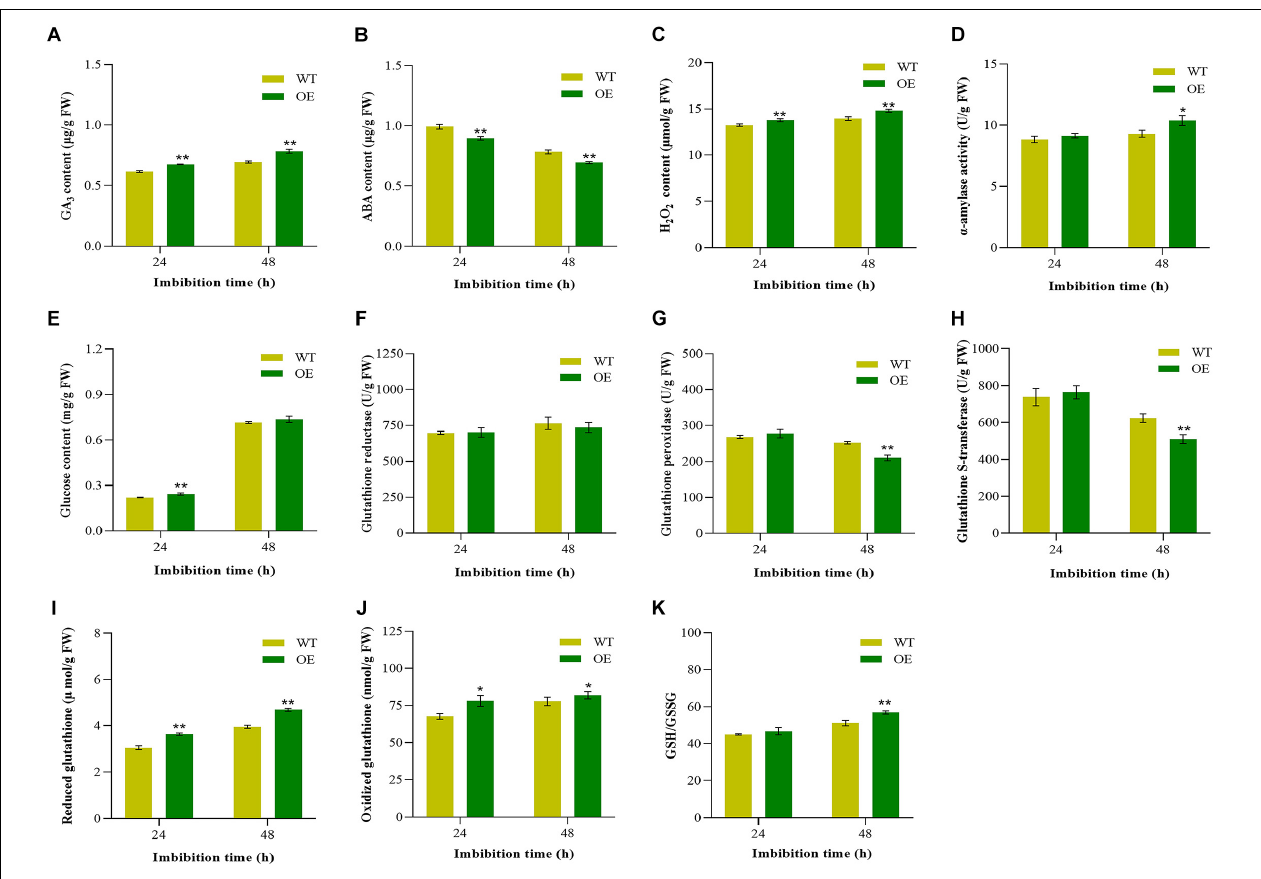
FIGURE 5 | Comparison of endogenous hormones, H 2 O 2 , starch mobilization, glucose, and glutathione metabolism between the overexpressing lines and the WT during seed germination of tobacco. (A) GA 3 content; (B) ABA content; (C) H 2 O 2 content; (D) α -amylase activity; (E) Glucose content; (F) Glutathione reductase; (G) Glutathione peroxidase; (H) Glutathione S-transferase; (I) Reduced glutathione; (J) Oxidized glutathione; (K) the ratio of reduced glutathione and oxidized glutathione. Each column represents the means ± SD. * and ** indicate the significant difference compared to WT at 5 and 1% levels, respectively.